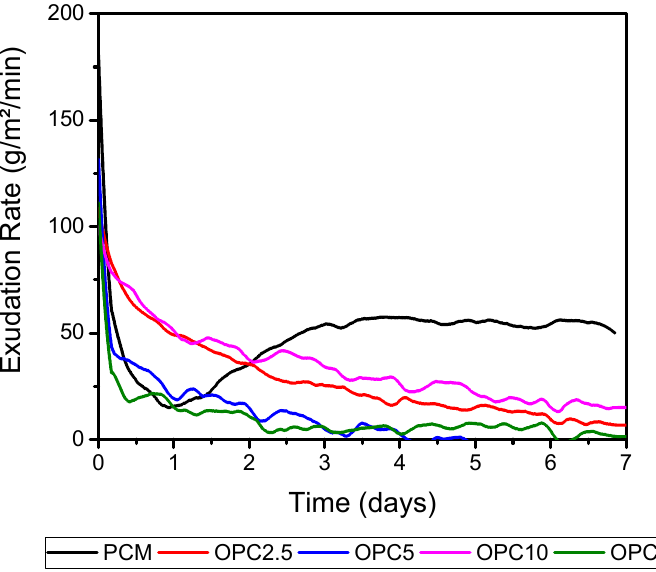
Figure 11. Exudation rate during the curling of mortar screeds.